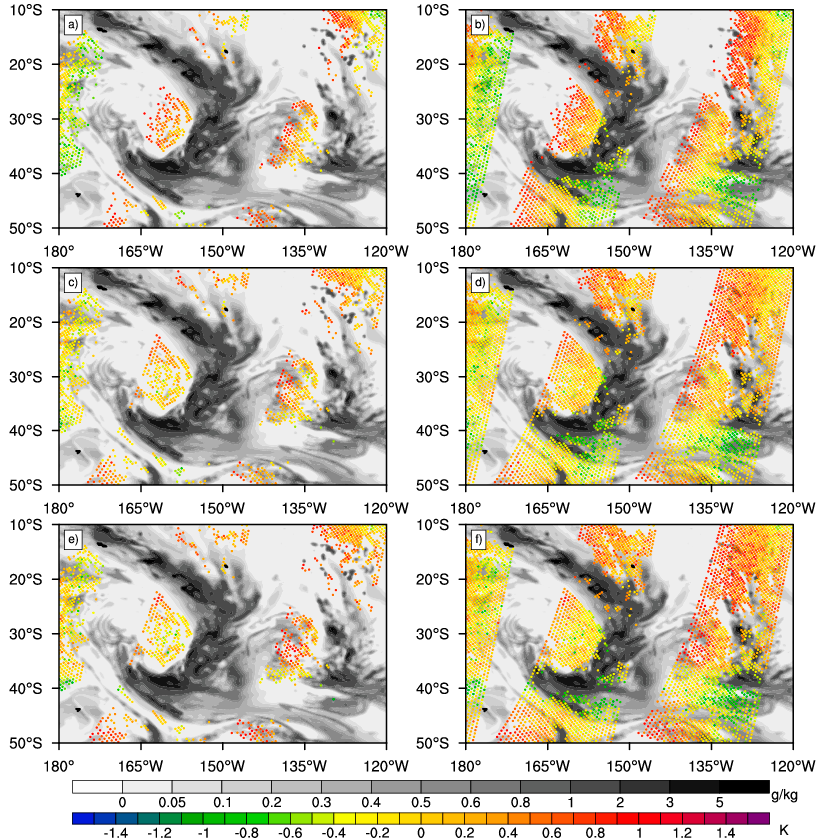
Figure 9. Spatial distribution of observations that passed the cloud detection threshold in the CTRL (a, c, e) and DCS05 (b, d, f) experiments based on the O-B of MWTS-2 channel 5 data (a, b), channel 6 data (c, d) and channel 7 data (e, f) at 1200 UTC on December 10, 2018. The monochrome background is the same as that used in Figures 8.